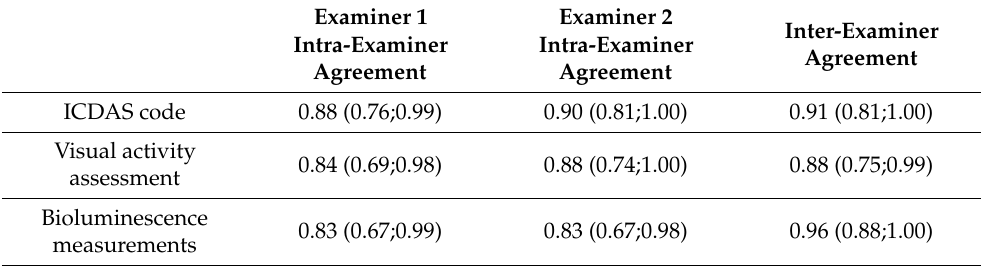
Table 1. Kappa values for examiner agreement prior to the clinical study (95% confidence interval in